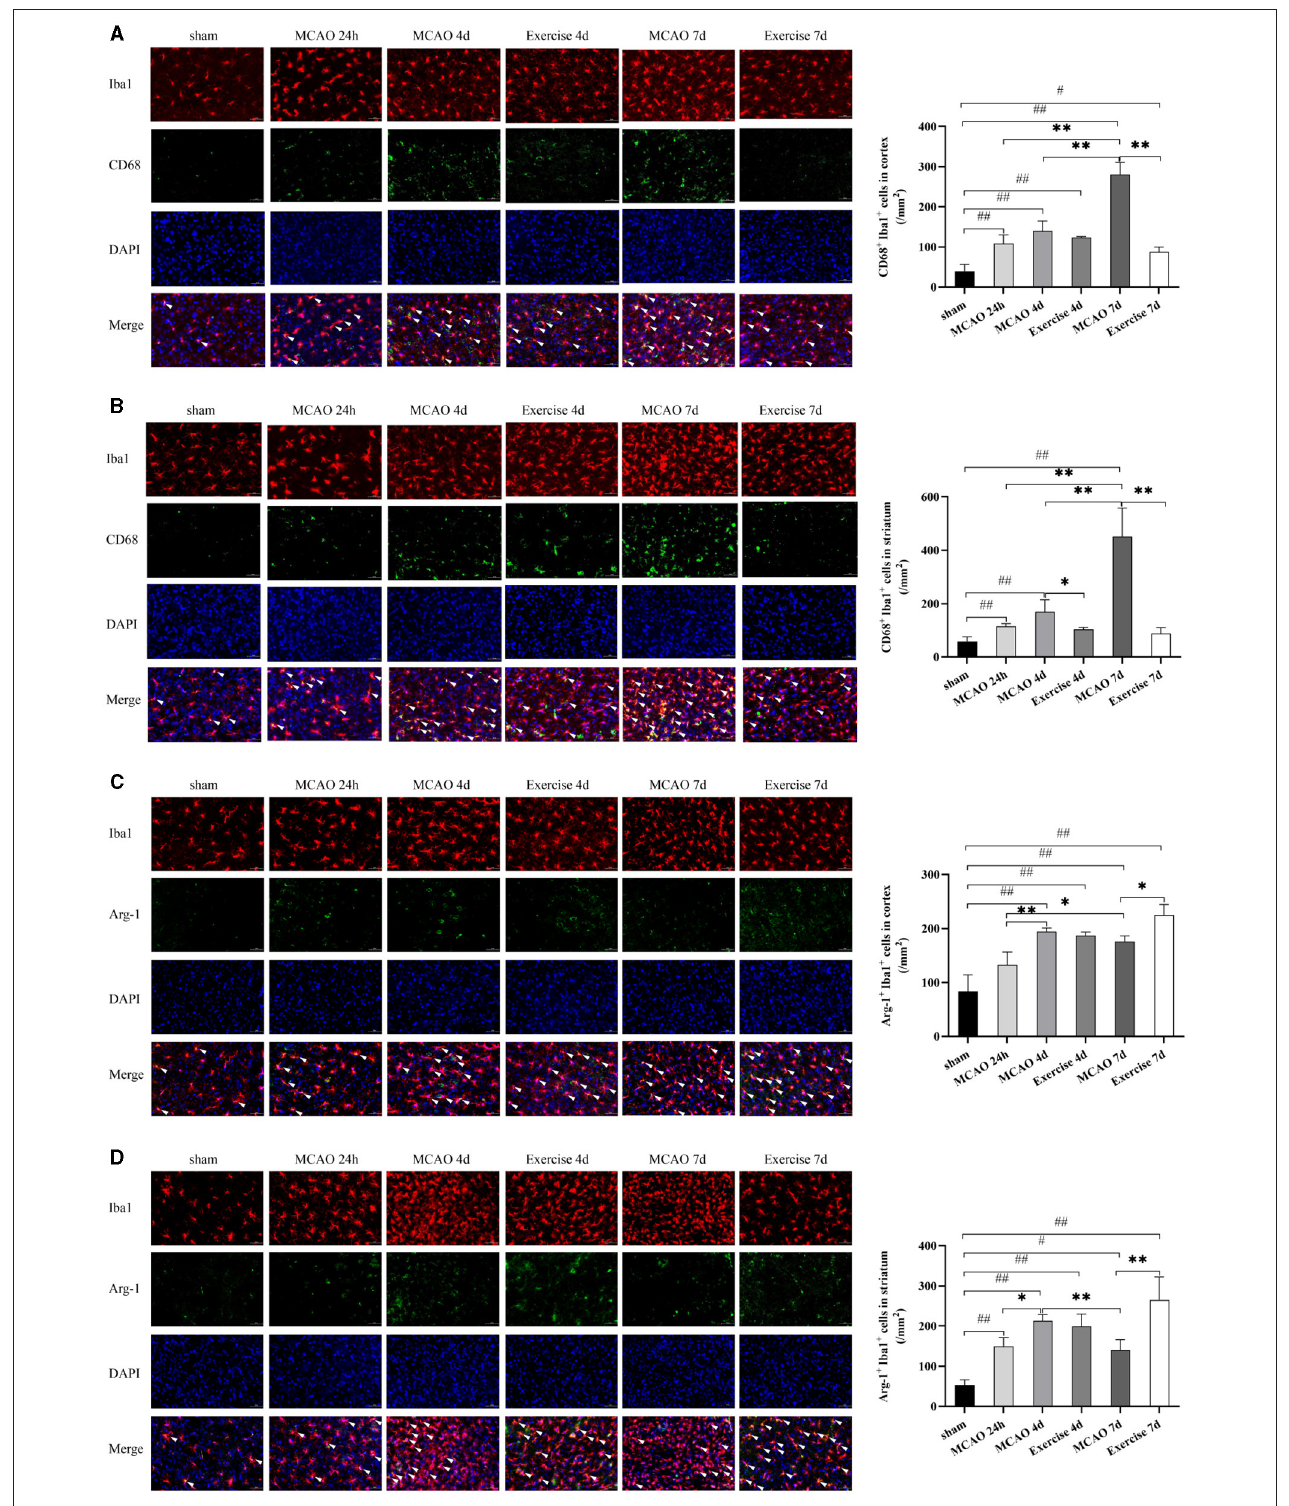
FIGURE 3 | Treadmill exercise inhibited M1 microglia polarization and promoted microglia polarization toward M2 Phenotype after MCAO. Double immunostaining with Iba1 and CD68 or Arg-1 at 24h, 4, and 7d among the sham, MCAO and exercise groups was performed in this study. (A,B) representative images of immunostaining with Iba1 and CD68 in the cortex (A) and striatum (B) and the corresponding histogram was shown on the right side. (C,D) representative images of immunostaining with Iba1 and Arg-1 in the cortex (C) and striatum (D) and the number of double-positive cells was shown on the right side. White arrows indicated the double-positive cells. Bar = 50 µ m for all images, n = 3 per group. # P < 0.05, ## P < 0.01 vs. sham group; * P < 0.05, ** P < 0.01 vs. MCAO group.